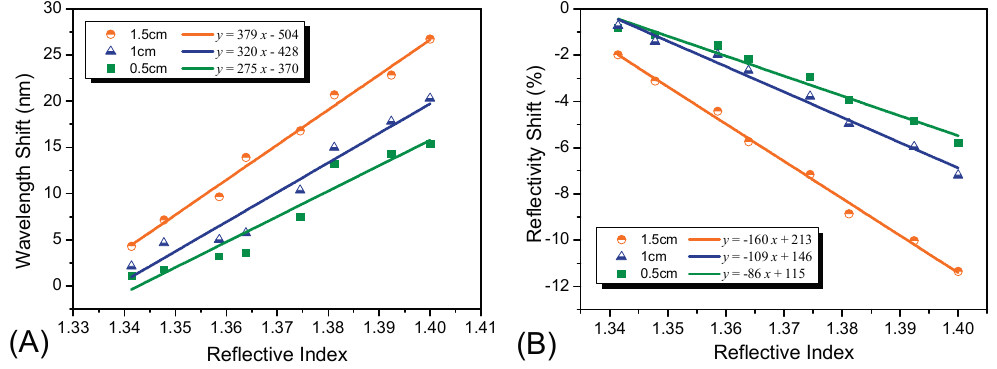
Figure 4. Refractive index sensitivities of the Ag NP-based sensors with different sensing lengths of 0.5 cm, 1 cm, 1.5 cm. ( A ) illustrates the wavelength shifts of the Ag NPs-based sensors with three different sensing lengths; ( B ) illustrates the reflectivity shift of the Ag NP-based sensors with three different sensing lengths.